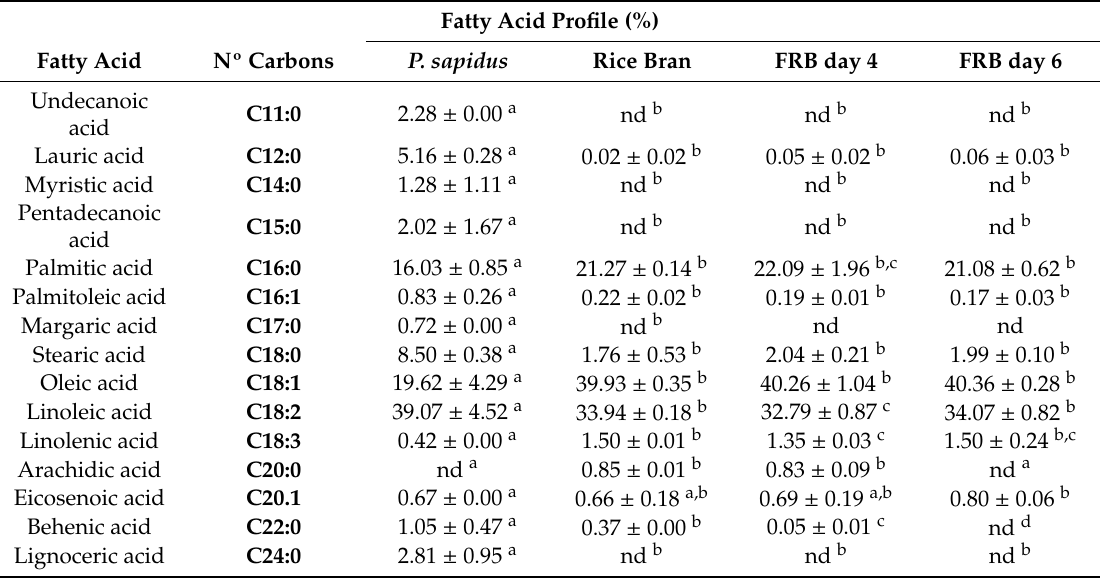
Table 2. Fatty acid composition of P. sapidus , rice bran (unfermented), and fermented rice bran at di ff erent cultivation times (4 and 6